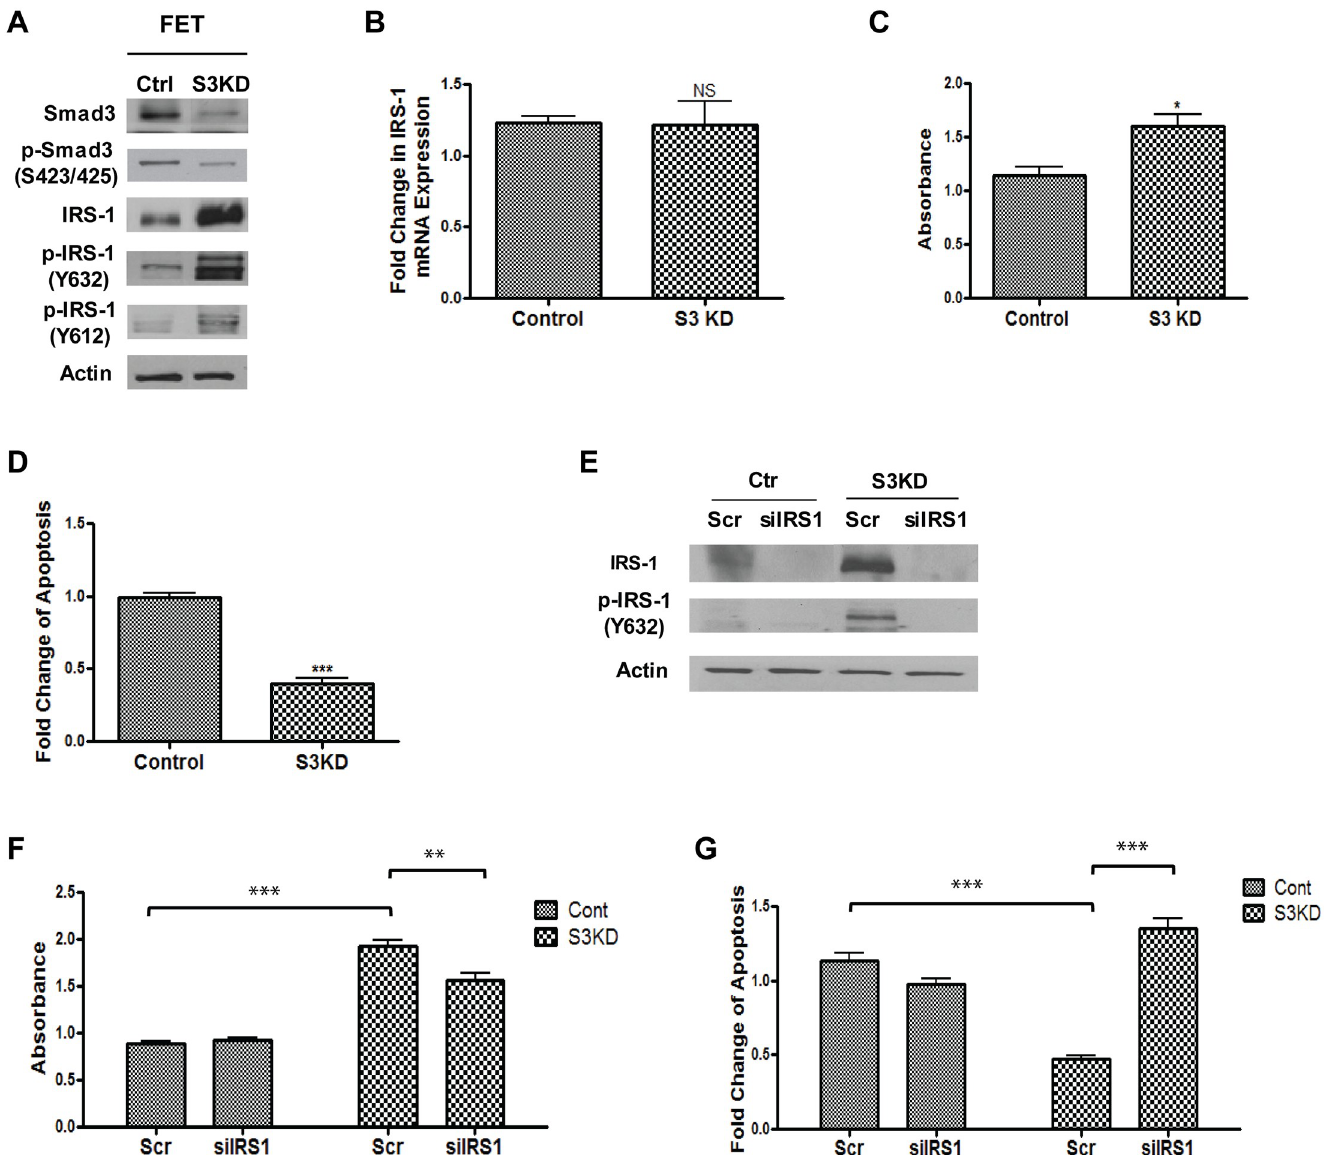
Fig 3. Knockdown of Smad3 led to increased expression and phosphorylation of IRS-1, which contributed to Smad3 knockdown-induced increasedproliferation and decreasedapoptosis under stress. (A) knockdown of Smad3 in FET cells attenuated TGF β signalingand increasedIRS-1 expressionand phosphorylation. (B) knockdown of Smad3 in FET cells had little effect on IRS-1 mRNA expression. (C) MTT assays showedthat cell proliferation was increasedin Smad3 knockdown cells comparedwith control cells. (D) DNA fragmentation assays showedprotection from apoptosisin Smad3 knockdown cells comparedwith control cells under GFDS. (E) A siRNA pool targeting IRS-1 was transfected into FET-Smad3 knockdown and control cells. Expression and phosphorylation of IRS-1 were markedly reducedin siRNA-transfected cells comparedwith scrambled siRNA-transfected control cells. (F) MTT assays showedthat knockdown of IRS-1 expressionpartially prevented Smad3 knockdown-mediated increasedproliferation of FET cells. (G) DNA fragmentation assays showedthat knockdownof IRS-1 expressionabrogatedSmad3 knockdown-mediatedreduction of apoptosisunder GFDS. For F and G, two-way ANOVA was used to compare the difference betweenCont Scr and S3KD Scr and Student’s t-test was used to compare the difference betweenS3KD Scr and siIRS-1. The data are presentedas the mean ± SD of three replicates. * P < 0.05, ** P < 0.01, *** P < 0.001.